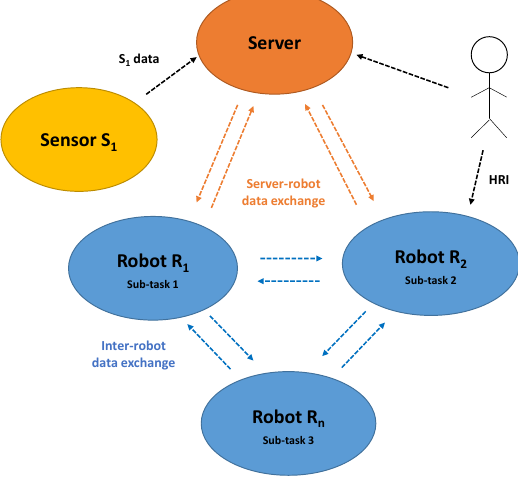
Figure 5. An example of a collaborative robotics